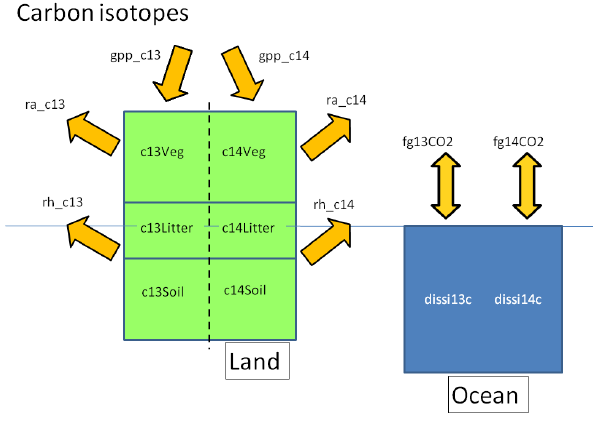
Figure 17. Carbon isotope diagnostics. Only report for models sim- ulating isotopes. We define c13Land = c13Veg + c13Litter + c13Soil and likewise for c14Land. As for cSoil, models with vertical dis- cretization should also report above and below 1m separately as c13SoilAbove1m and c13SoilBelow1m and likewise for